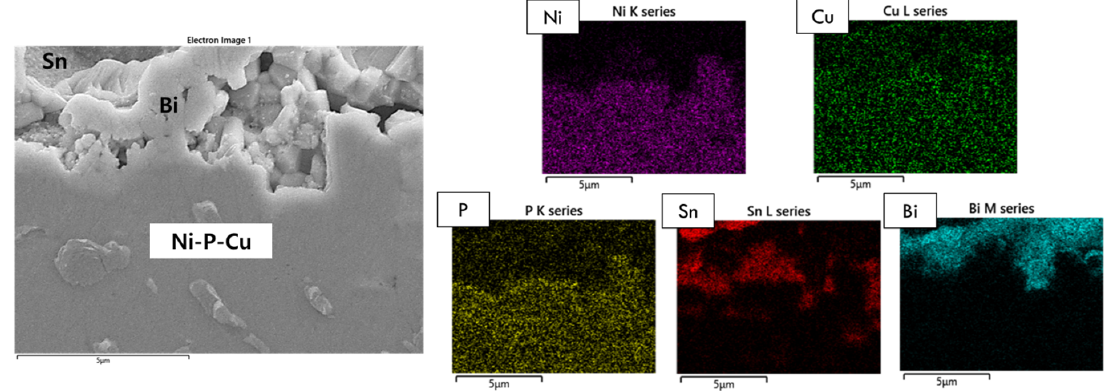
Figure 4. EDX elemental analysis of the Sn-58Bi-0.1Pt/ENIG interface after 500 h of aging.